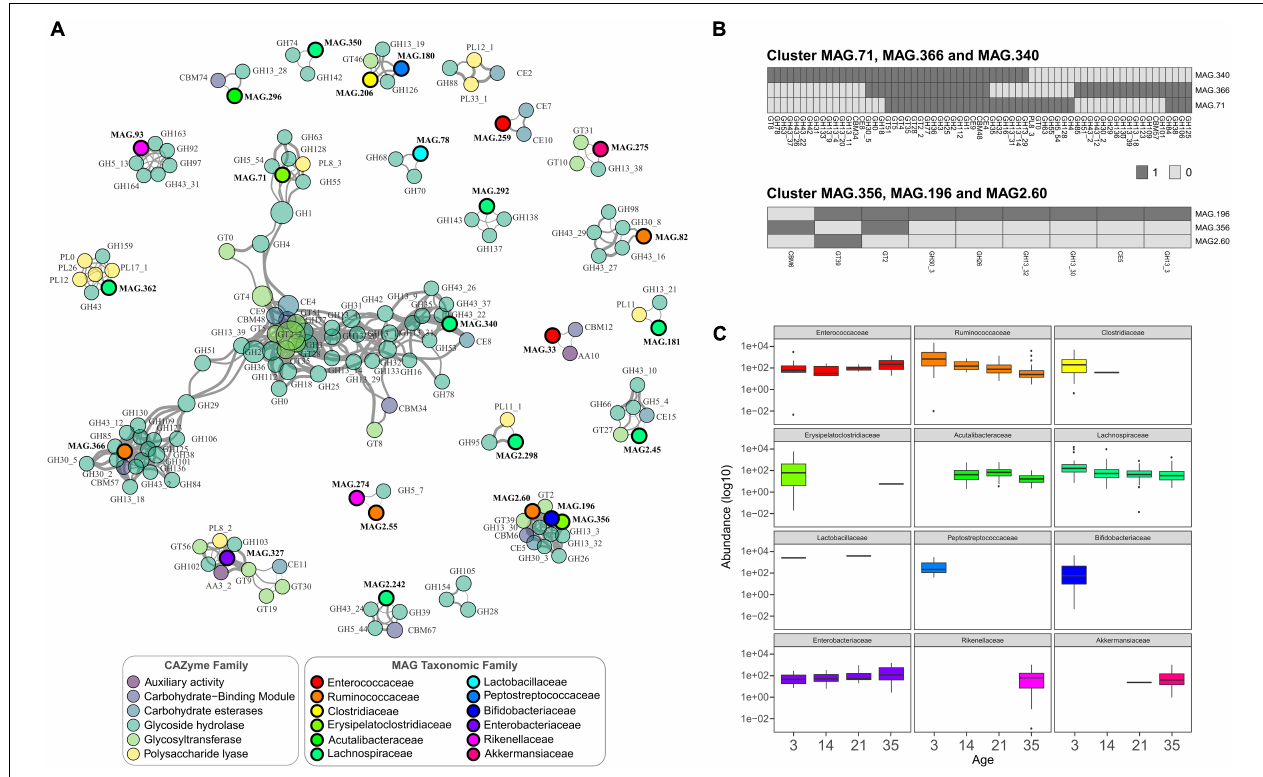
FIGURE 4 | (A) Co-occurrence network of main CAZymes genes and main taxonomic families. Nodes represent CAZymes genes (colored by CAZyme family) or phylogenetic families, and their size represents their abundance. The edges thickness is proportional to the Spearman’s rank correlation between the nodes; only strong and significant correlations are shown (Spearman’s rank coefficient > 0.8, p < 0.01). (B) Heatmaps of the presence and absence of CAZymes in the MAGs from two of the main clusters shown in (A) . (C) Abundance of the taxonomic families of the MAGs represented in the co-occurrence network. The boxplots are colored based on taxonomic families following the same scheme as shown in (A)